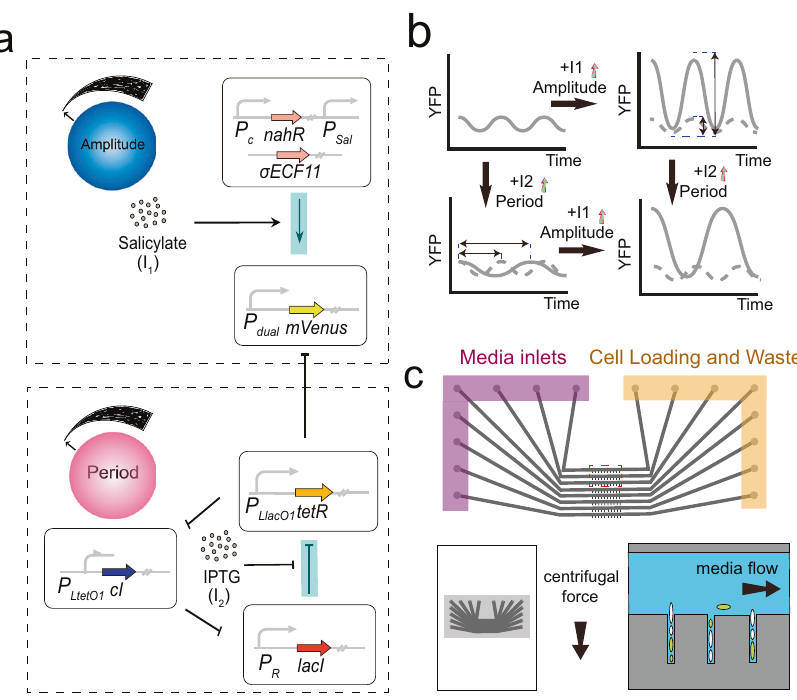
Fig. 1 Construction and observation of the independent regulation of the repressilator. a Construction of the gene circuits. The mVenus gene, which acts as a reporter, can be regulated by a dual-input promoter. Salicylate can regulate the expression level of the mVenus gene, which leads to a change in amplitude. IPTG can regulate the time of the state switch, which leads to a change in period. b Schematic diagram of the independent regulation. Input I 1 regulates the amplitude and Input I 2 regulates the period independently. The combination of I 1 and I 2 can lead to an oscillation with an expected amplitude and period. c Design of the mother machine micro fl uidic chips to observe the repressilator under different conditions. Eight combinations of different conditions can be observed in an Fig. 2a, b, which showed microscopic images of the whole channel over 15 h.